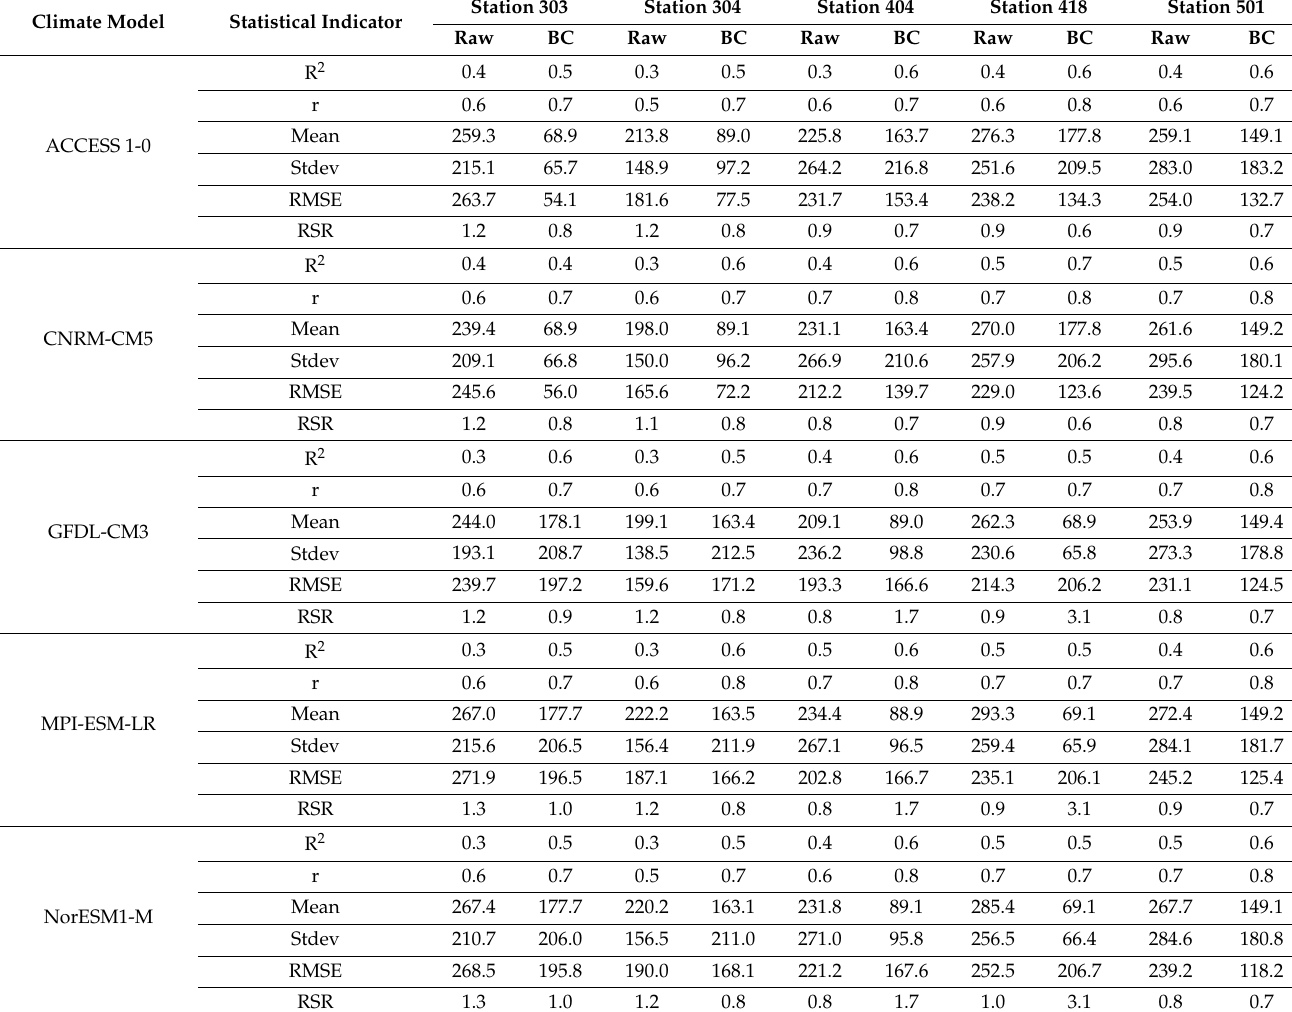
Table 2. The statistical performance of different climate models at various stations before and after application of bias correction. ‘Raw’ represents the statistical performance of the climate model before bias correction, while BC represents after bias